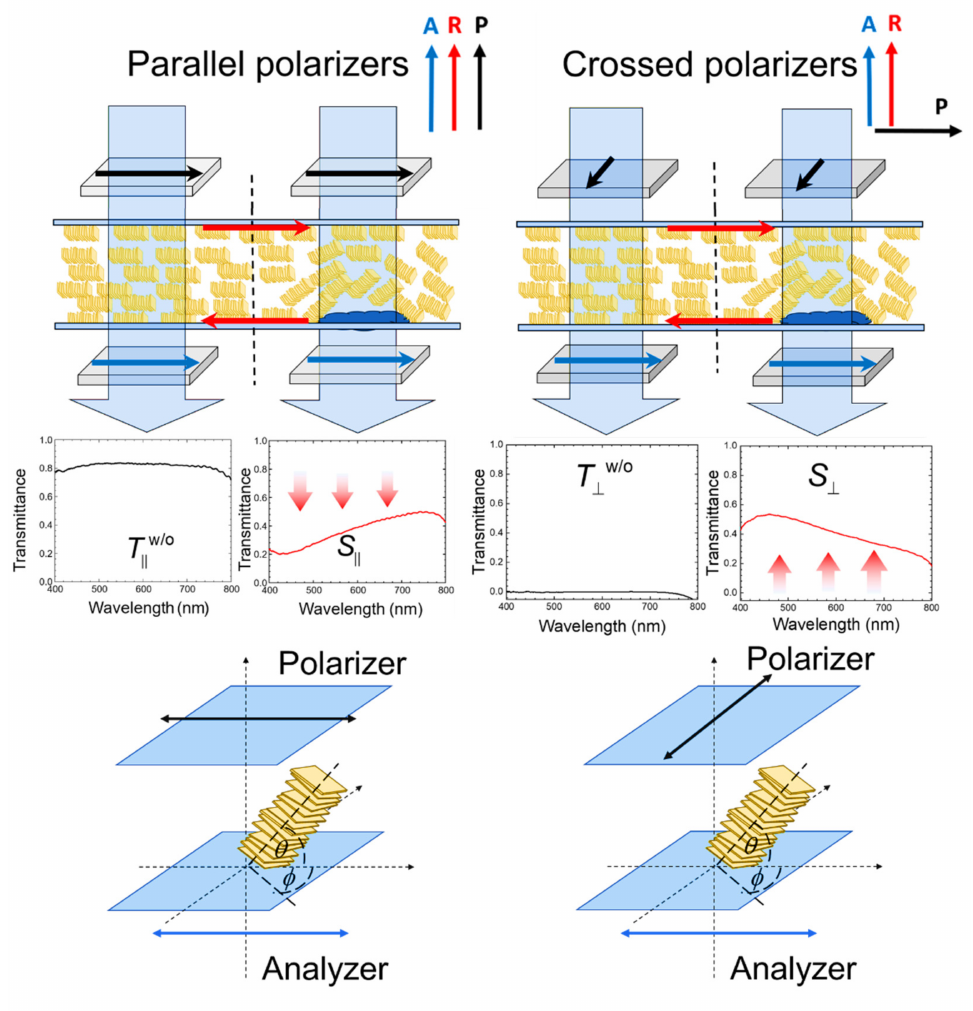
Figure 3. Transmission measurements with parallel and crossed polarizers in the LCLC-based biosensor. When biomolecules are immobilized at the LC–glass interface, leading to disturbance in the planar alignment of LCLC, transmittance decreases when analyzed with parallel polarizers (left panel) and increases when analyzed with crossed polarizers (right